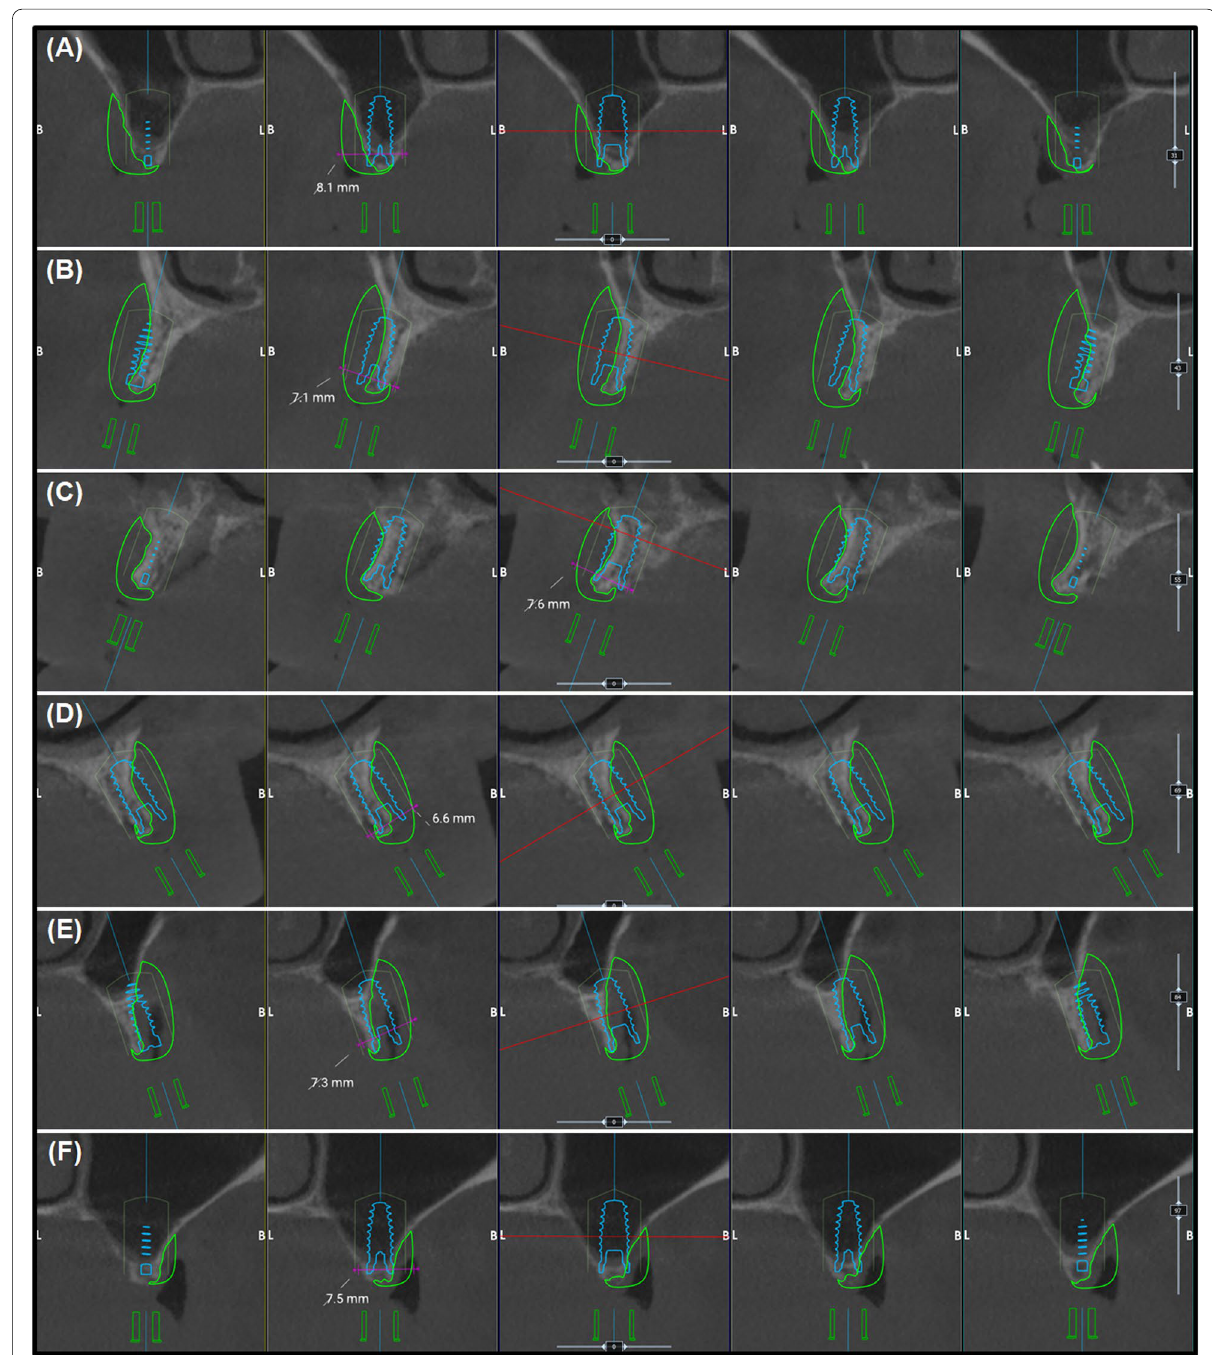
Fig. 2 Digital planning of the special bone block design (in J‑shaped) with implant placement position for the regions: A 16, B 14, C 12, D 22, E 24, and F